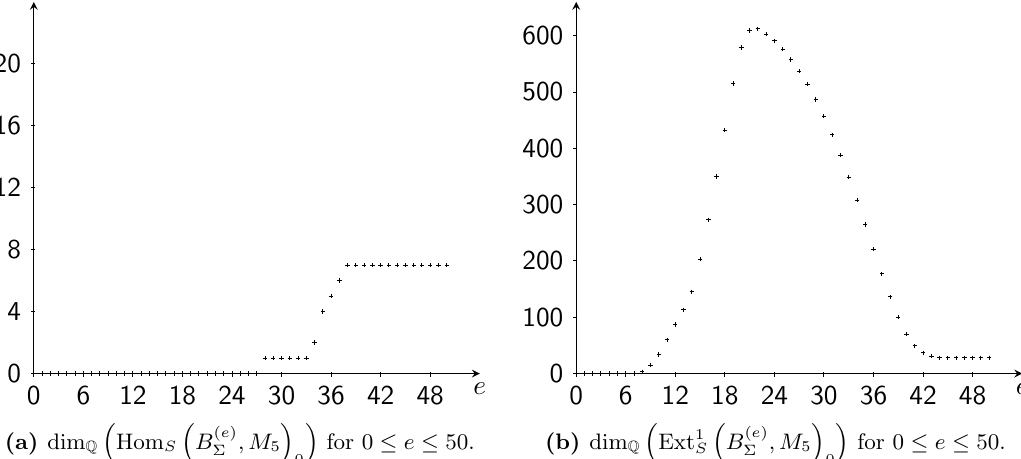
Figure 10. Computing the sheaf cohomologies of f M 5 with plesken